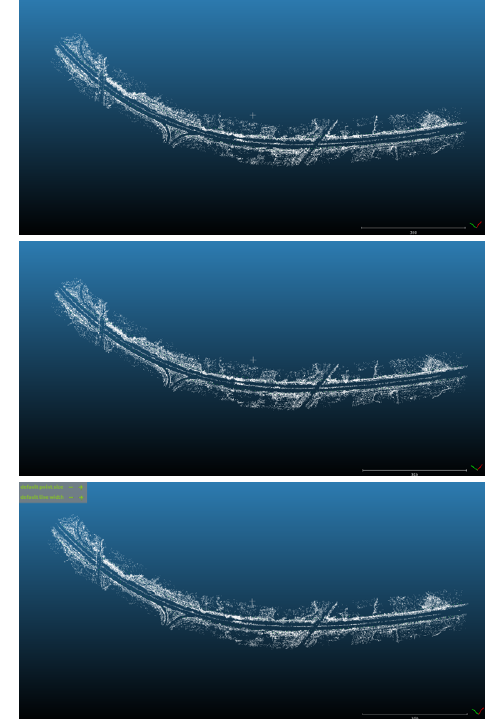
Figure 10. Tie-point cloud after BBA in the case of position uncertainty level 1 (top), level 2 (middle) and 3 (bottom). One can check that the structure of the tie-point is stable even with a level 3 of disturbance acting on the position.